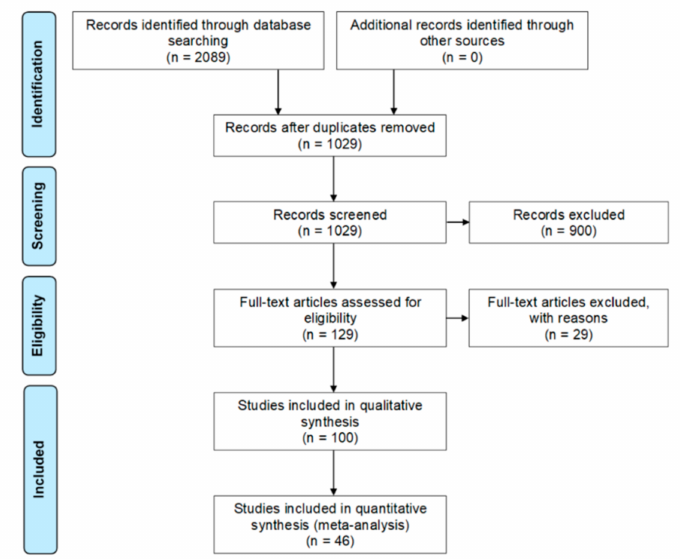
Figure 1. PRISMA flow diagram of this systematic review. Adapted from Moher et al. [32]. Compliance with the items in the statement guideline is presented in Supplementary Table